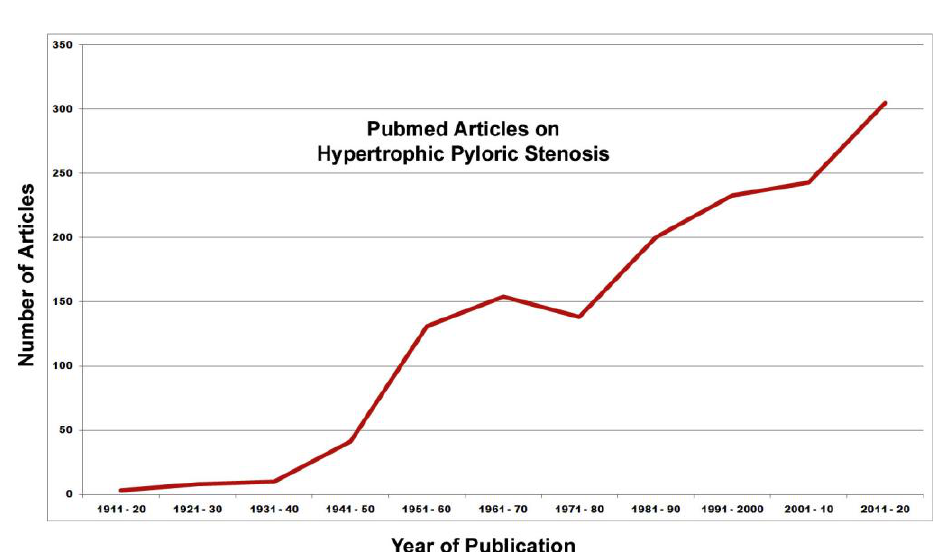
Figure 3: Number of Pubmed-indexed articles on Hypertrophic pyloric stenosis published during the last 100 years. (Plots for 2011 -20 period were calculated by projecting the number of articles published during